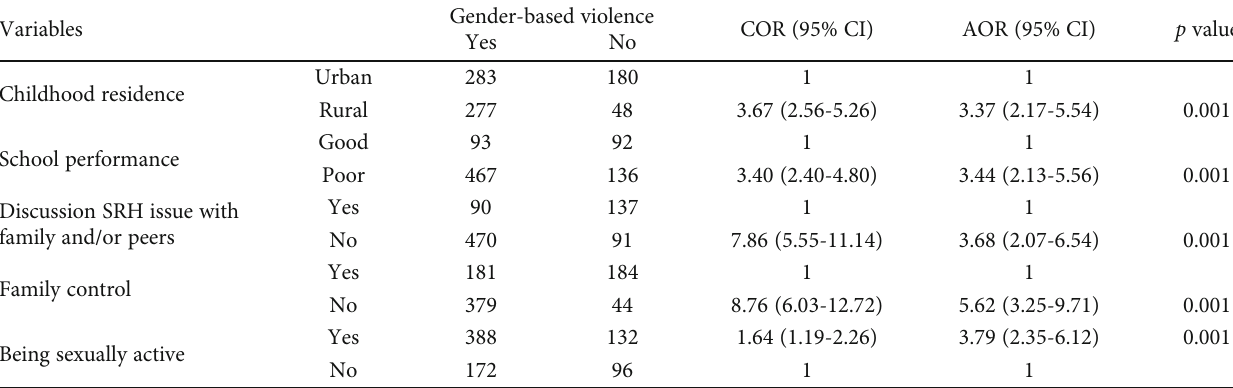
Table 4: Factors associated with gender-based violence among female night students in Bahir Dar city, Amhara region, Ethiopia, 2019. Variables